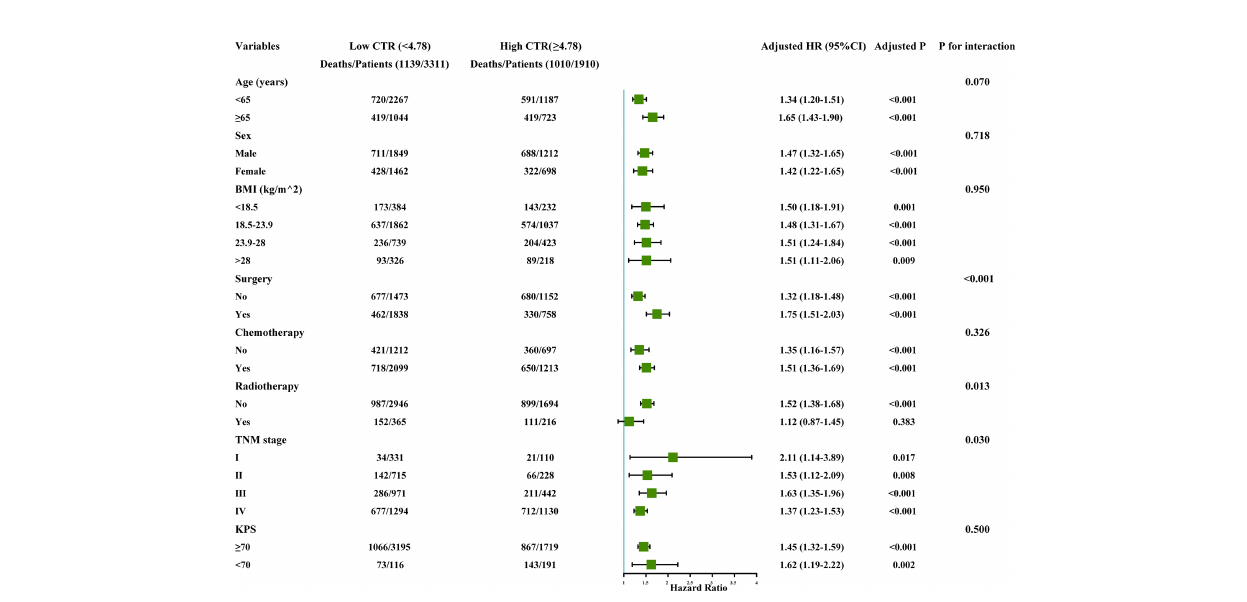
FIGURE 5 | The subgroup analysis of the CTI in the total cohort of patients with cancer. Adjusted for age, sex, TNM stage, BMI, tumor types, KPS, surgery, chemotherapy, radiotherapy, smoking, alcohol, nutritional intervention, hypertension, coronary heart disease, diabetes, and TSF. CTI, C-reactive protein-triglyceride glucose index; BMI, body mass index; KPS, karnofsky performance status; TSF, triceps skin